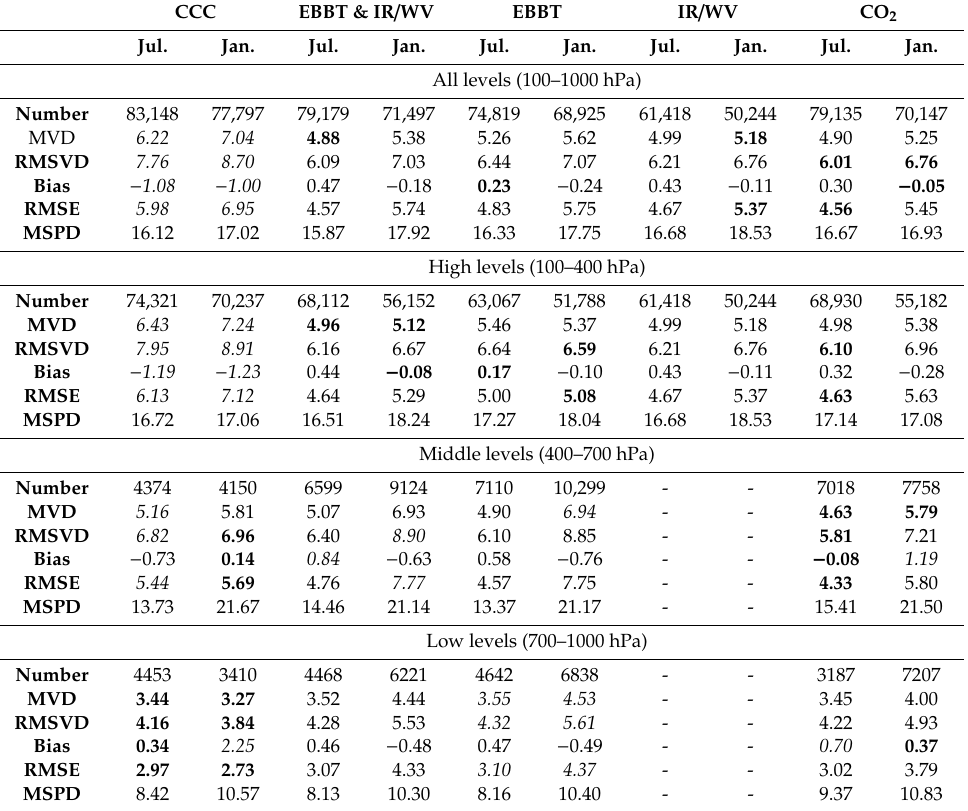
Table A4. Same as Table A3 except that rawinsonde was used as validation data.